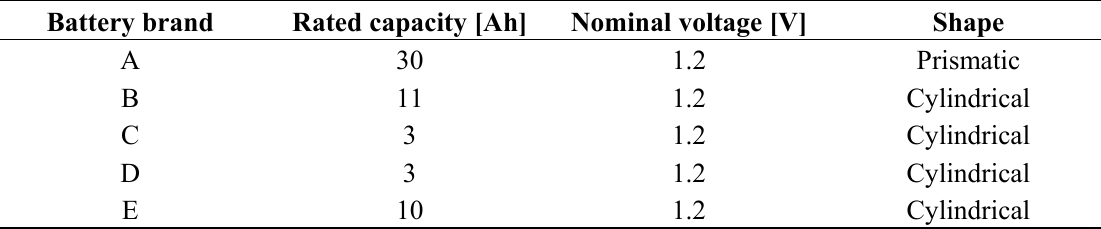
Table 5. Specifications studied nickel-metal hydride.